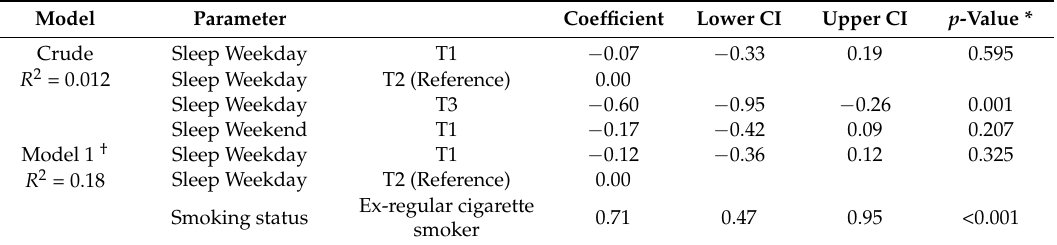
Table 3. Coefficient estimates from the multiple regression models of the association between sleep duration on weekdays and healthy dietary pattern as the